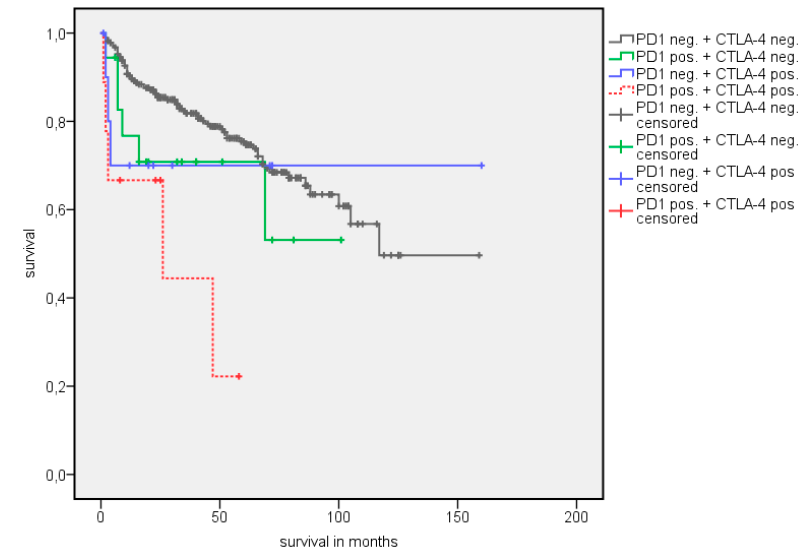
Figure 5. Kaplan Meier analysis: Association of CTLA-4 expression in TIMC with CSS in all RCC patients.